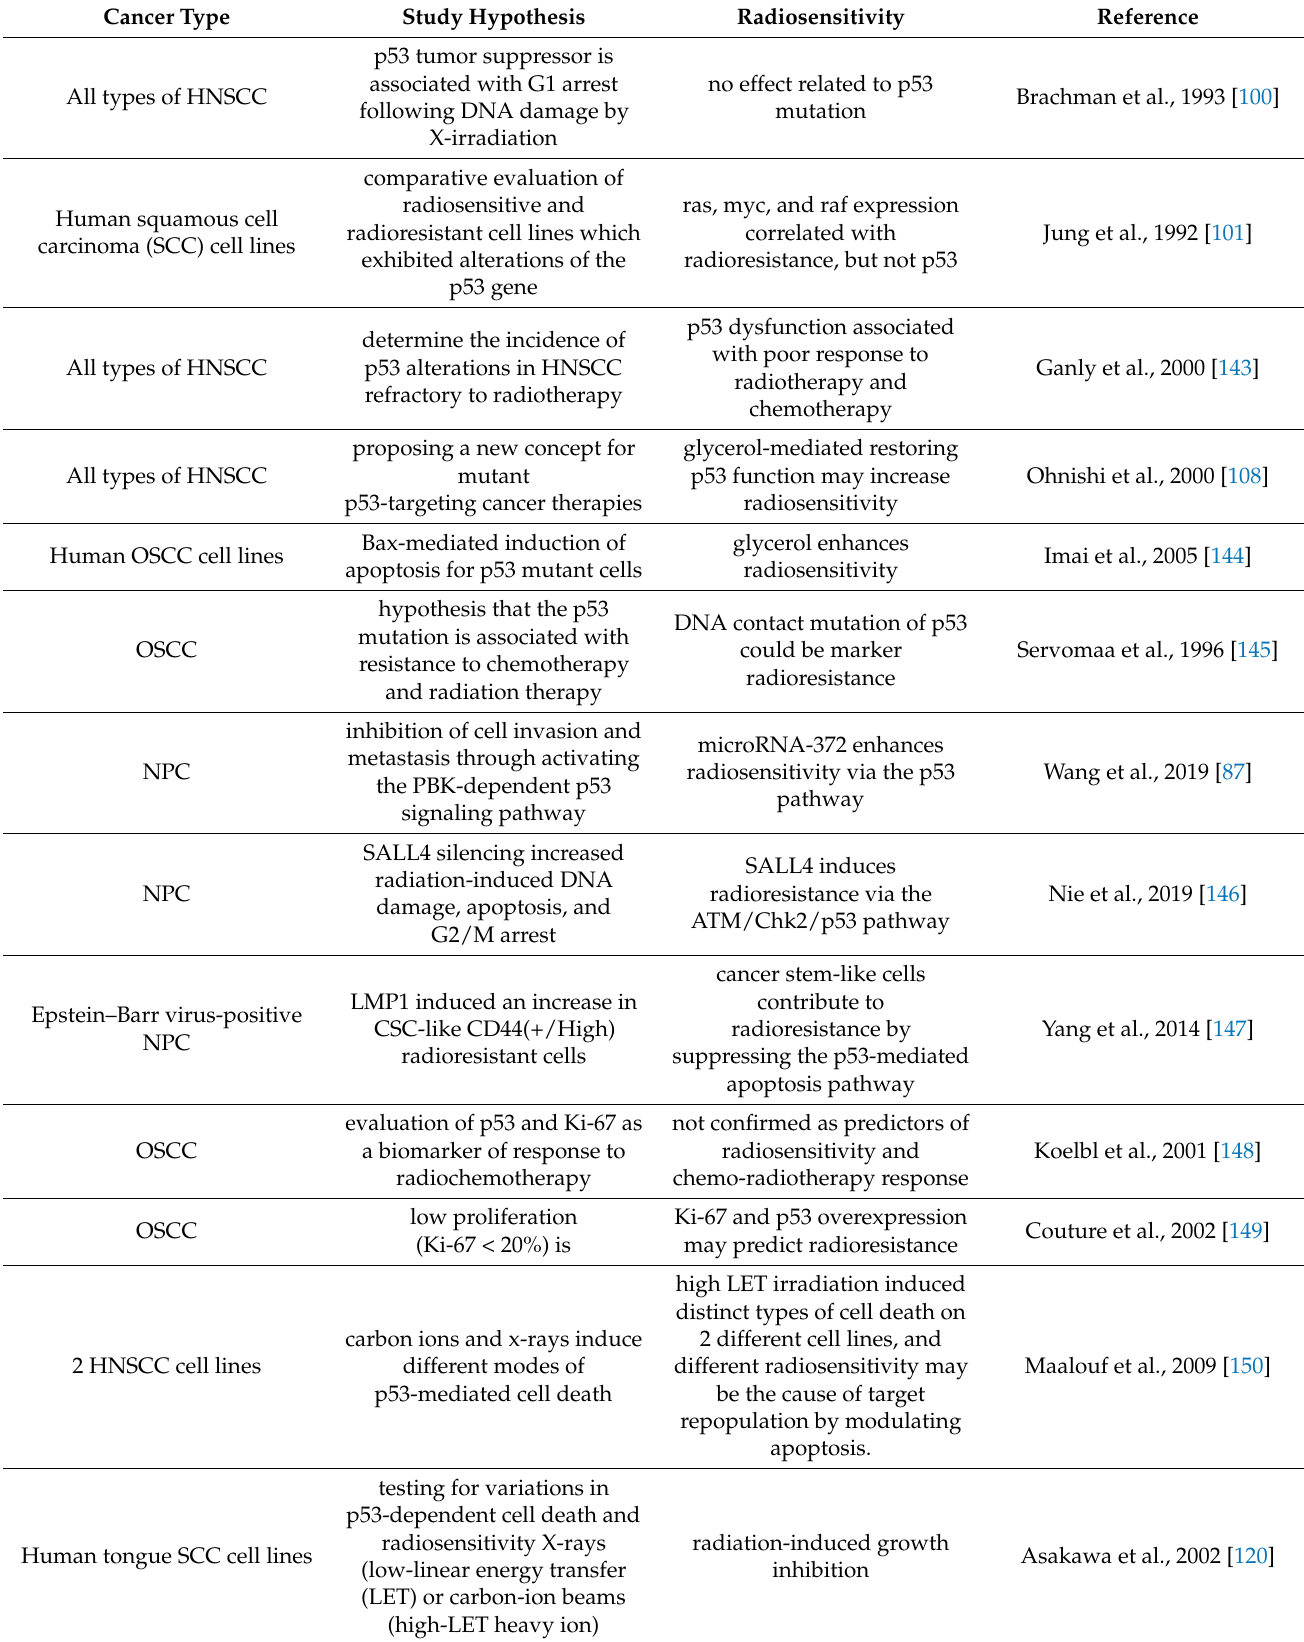
Table 2. p53 and HNSCC—implication in radiosensitivity and